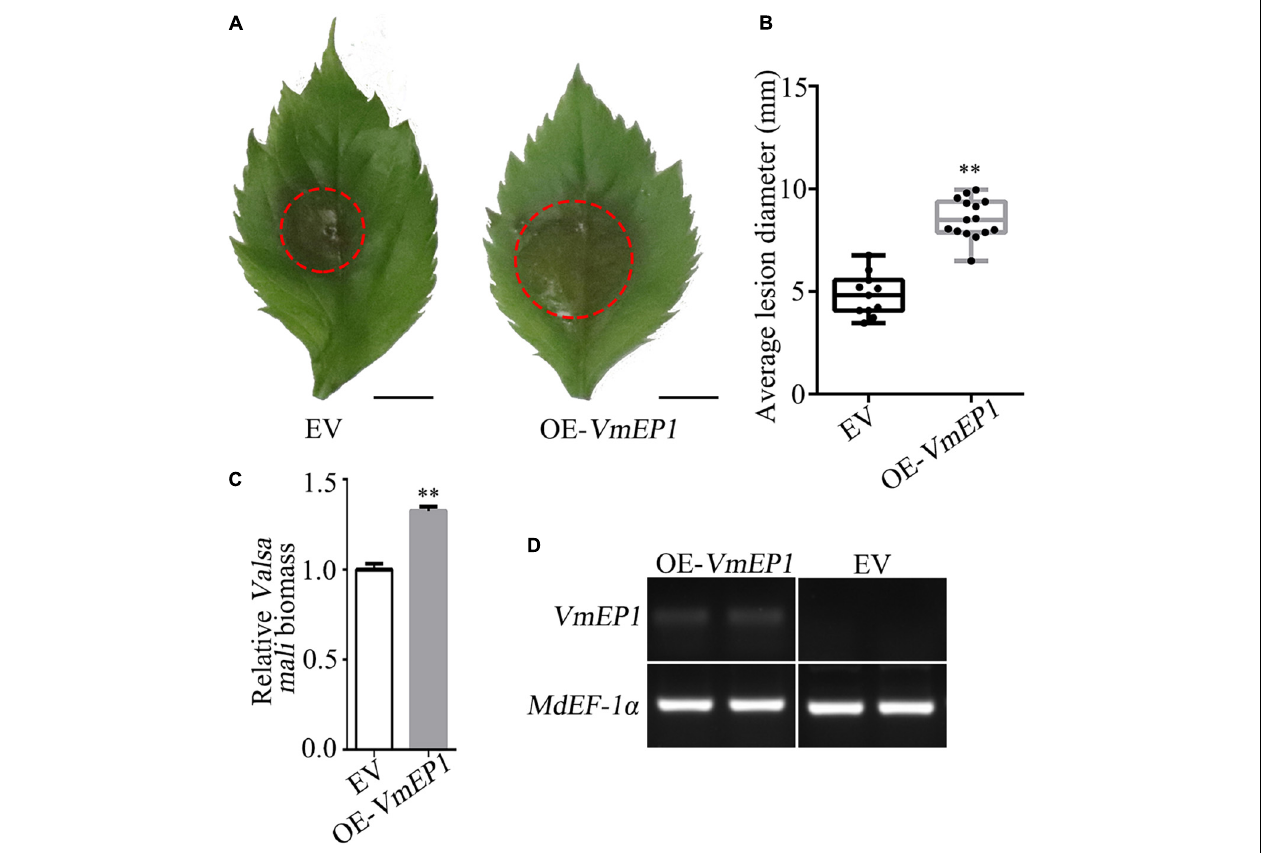
FIGURE 1 | The transient expression of Valsa mali effector protein 1 ( VmEP1 ) in apple facilitates V . mali infection. (A) Representative disease symptoms of the apple leave overexpressing VmEP1 at 36 hpi of V . mali . Bars = 5 mm. (B) The average lesion diameter of apple leaves in which VmEP1 is overexpression was evaluated at 36 hpi of V . mali . (C) V . mali biomass was measured with qPCR at 36 hpi of V . mali . The relative V . mali biomasses were normalized to the mean of the wild-type. (D) A semiquantitative RT-PCR analysis to assess the expression of VmEP1 . (A–D) EV, pCAMBIA1302 empty vector; OE- VmEP1 , apple leaves overexpressing VmEP1 . Mean ± SD; n > 10; ∗∗ P < 0.01; Student’s t